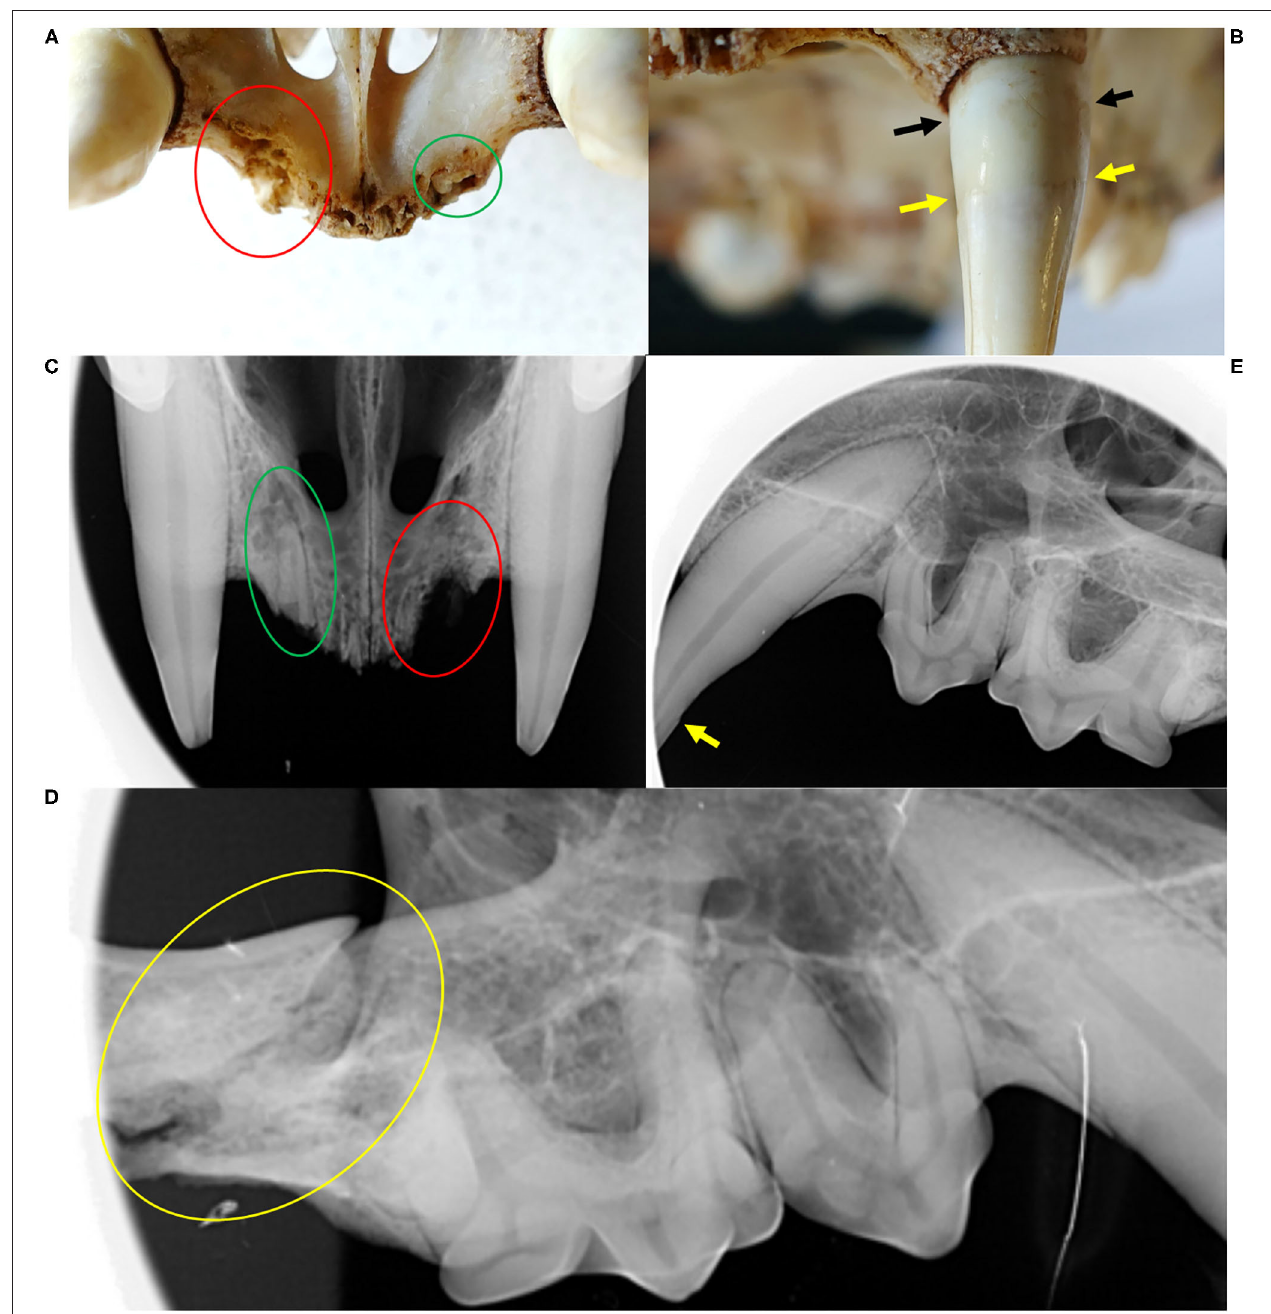
FIGURE 9 | Dental and bone lesions, Eurasian lynx ( Lynx lynx ), ADIN; (A) Prepared skull and (C) Radiograph, fronto-ventral view of the maxilla: all incisors missing with chronic osteomyelitis and osteolysis (red circle); visible root remnants of incisor 203 (green circle). (B) Prepared skull, frontal view of the maxilla: two distinct lines (cemento-enamel junction: yellow arrow, and gingival line: black arrow); (D) Radiograph, left lateral view of the maxilla: contour of the canine root perfectly followed by the alveolar wall; (E) Right lateral view of the maxilla: fracture of the zygomatic arch (yellow circle).